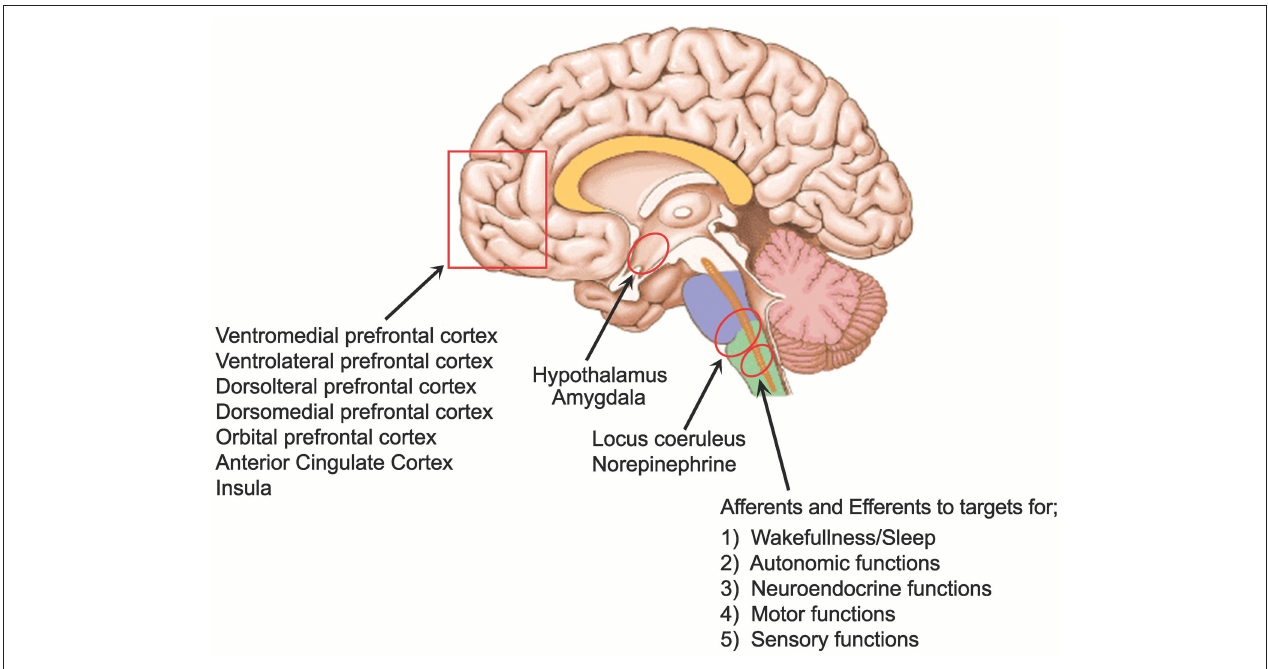
FIGURE 1 | Areas of strong LC connection and of interest to